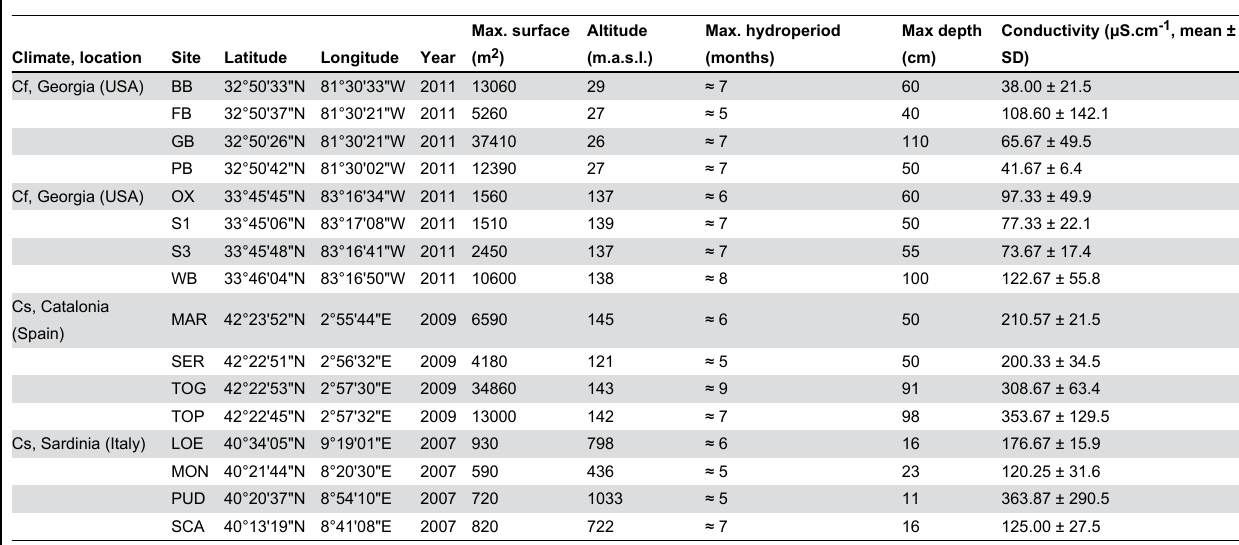
Table 1. Details of the 16 temporary wetlands selected for the case study.